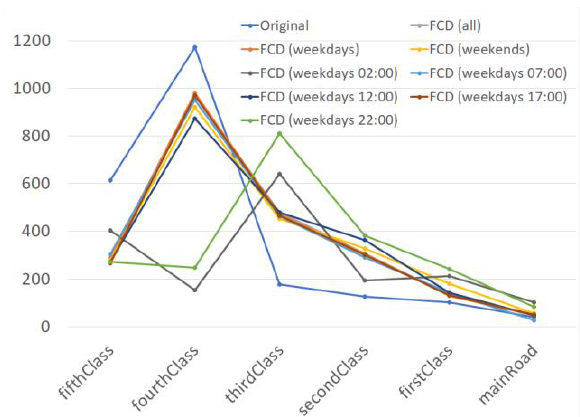
Figure 8 – Total length (in km) of network features falling in the 6 INSPIRE functional classes in the OTM original dataset and as results of the FCD speed based